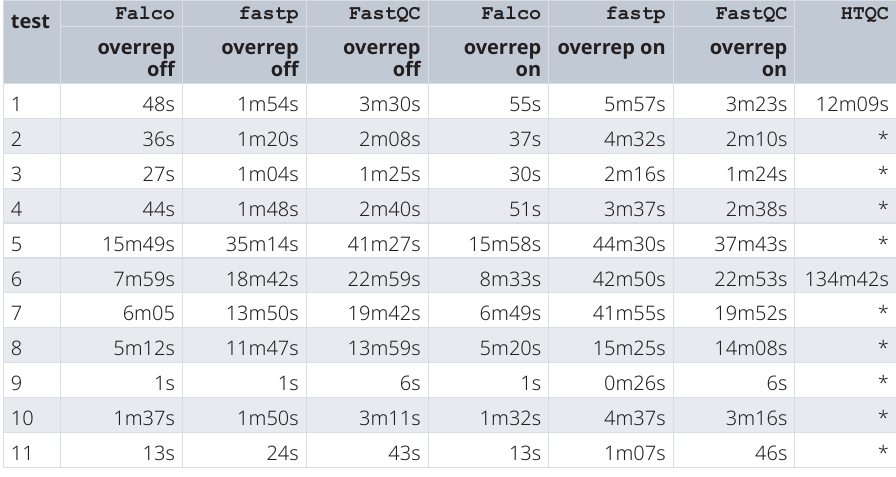
Table 3. Real run times for Falco , fastp and FastQC on uncompressed FASTQ format, with the overrepresented sequences module on and off. Asterisks (*) indicate tests in which tools did not run to